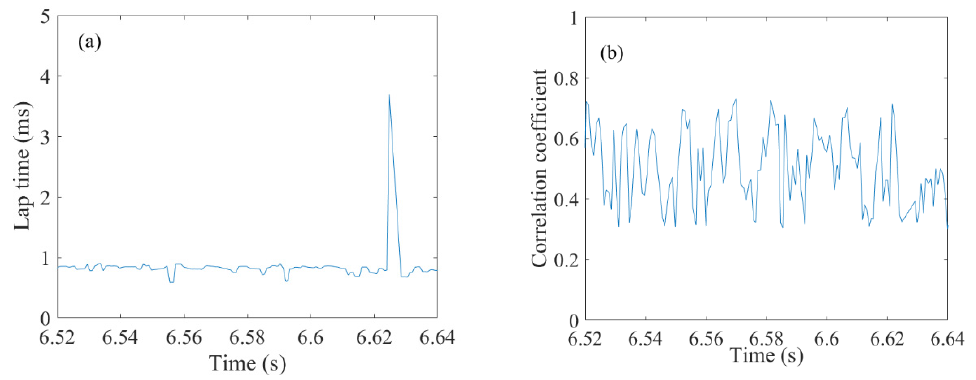
Figure 4. The rotating detonation experiment of B4: ( a ) original signal, ( b ) filtered signal, ( c ) frequency spectrum, and ( d ) time − frequency diagram.